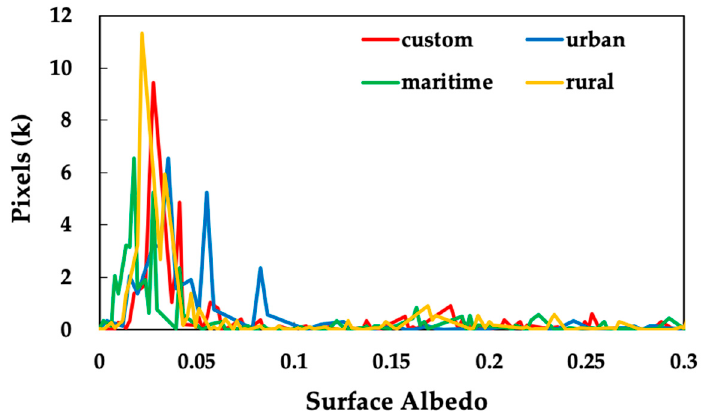
Figure 7. Comparison of ρ clear map from custom aerosol model and conventionally-used typical aerosol models (data from